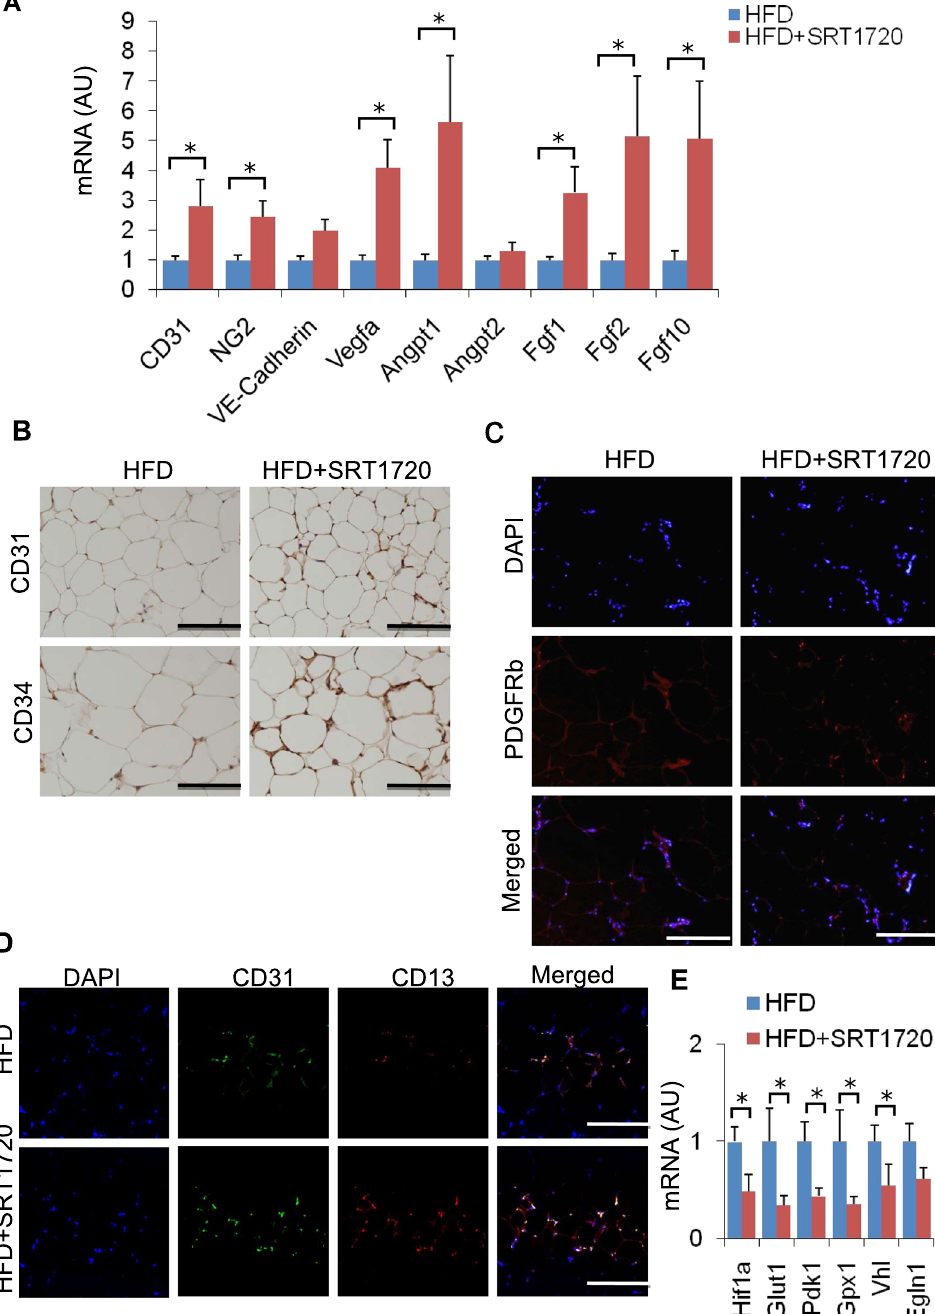
Figure 1. SRT1720 treatment enhances vasculature in eWAT. ( A ) mRNA expression of genes related to angiogenesis in eWAT. (n = 6–7). The results are shown as the mean ± SEM. * P < 0.05, ** P < 0.01. ( B ) Immunostaining of eWAT with anti-CD31 and CD34 antibody. ( C ) Immunofluorescence labeling of eWAT with anti-PDGFRb. ( D ) Immunofluorescence labeling of eWAT with anti-CD31 (green) and anti-CD13 (red) antibodies. Scale bar, 100 μ m. ( E ) Relative mRNA expression of hypoxia-related genes in eWAT from DIO mice treated with or without SRT1720 (n = 4–5 per group). The results are shown as the mean ± SEM. * P < 0.05, ** P <